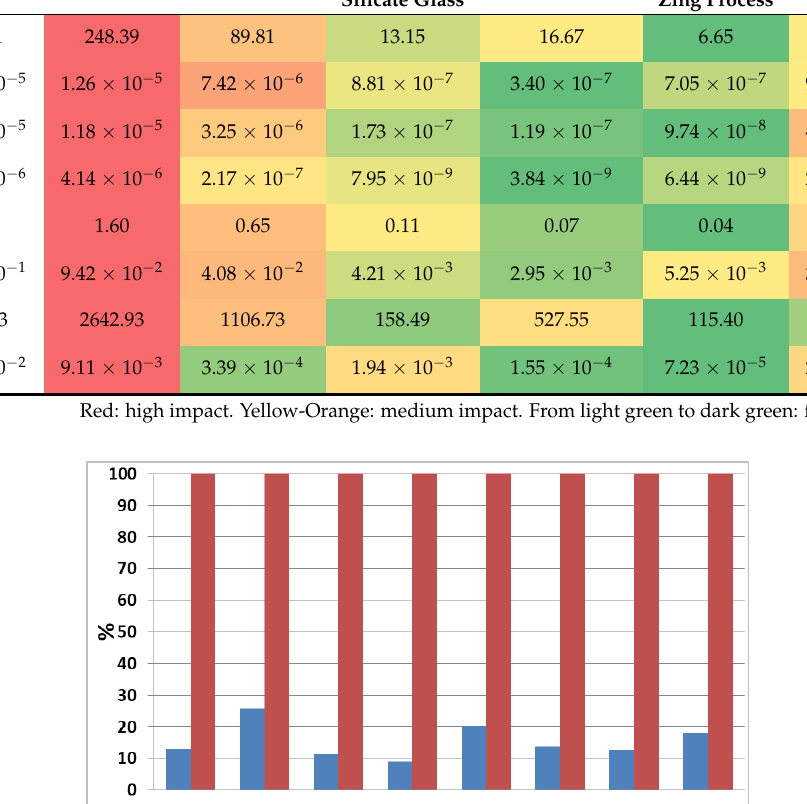
Table 10. Impact at midpoint level for the pilot plant analyzed.